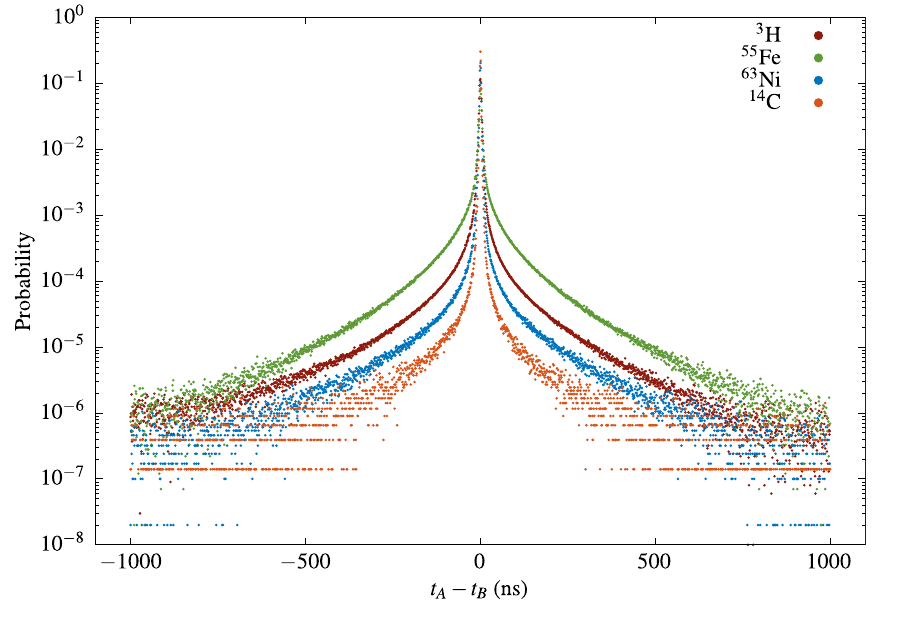
55 3 63 14 Fe, H, C and